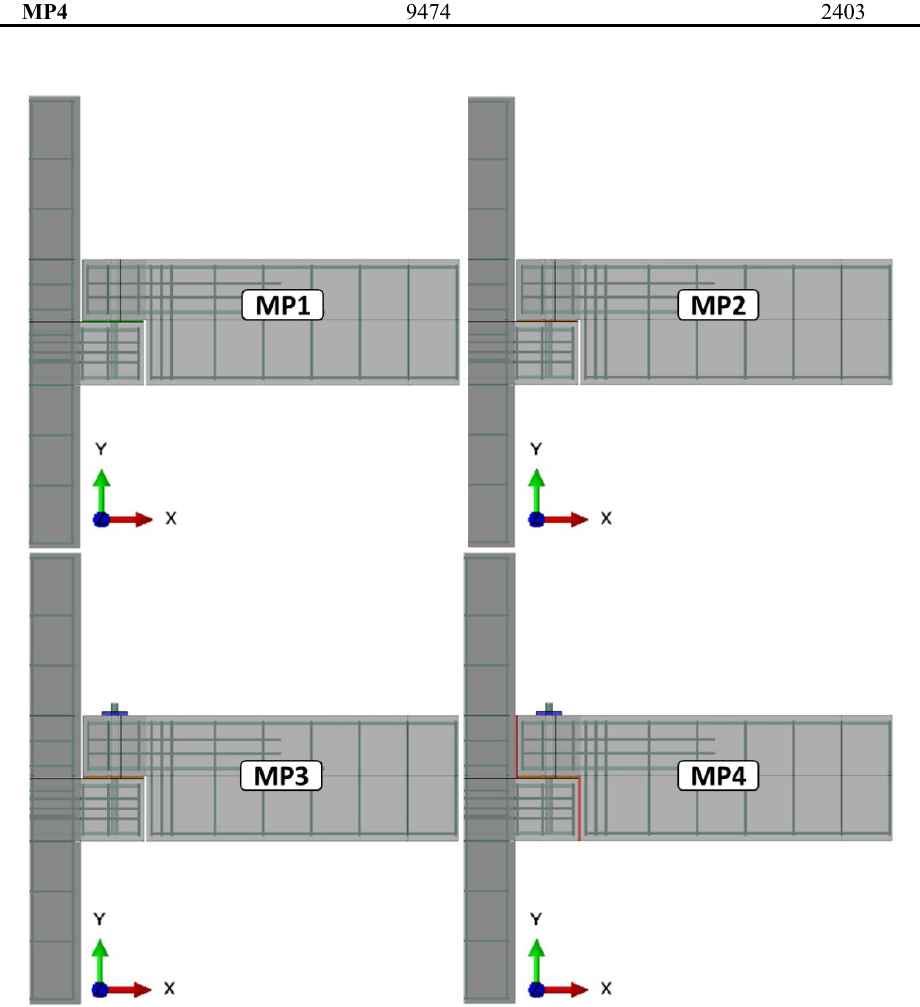
Figure 10. Numerical